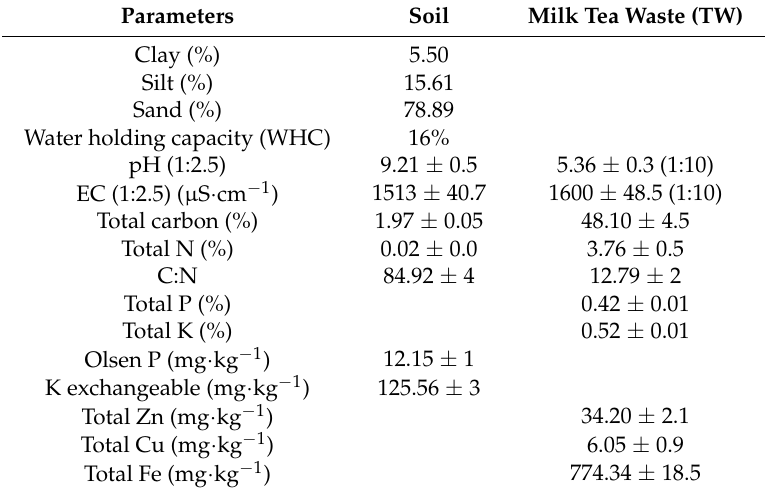
Table 4. Properties of soil and milk tea waste used in the experiment (mean ± standard error; n = 3).